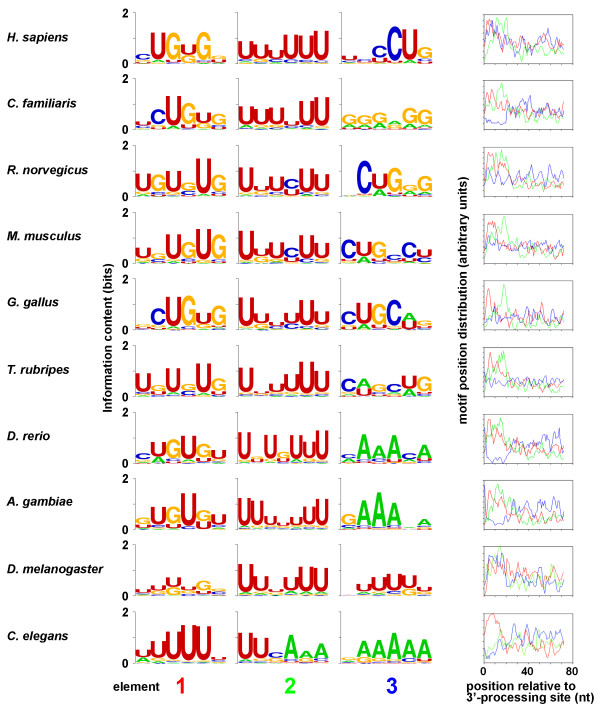
Gibbs Recursive Sampler analysis of the DSE regions. Typical results are shown from Gibbs Recursive Sampler [30] analysis of the organism-specific downstream sequence sets. The sequence content and positioning distribution of the motifs are represented by Sequence Logos [32] and line plots, respectively. The analysis allowed patterns to grow up to 10 nt in length, however the resulting patterns were consistently hexamers or heptamers, as shown. Positioning distributions were extracted from the output file and displayed graphically with a custom perl script. Elements 1, 2, and 3 are represented in the line plot as red, green, and blue lines, respectively. Full parameter lists for the analysis are described in Methods.